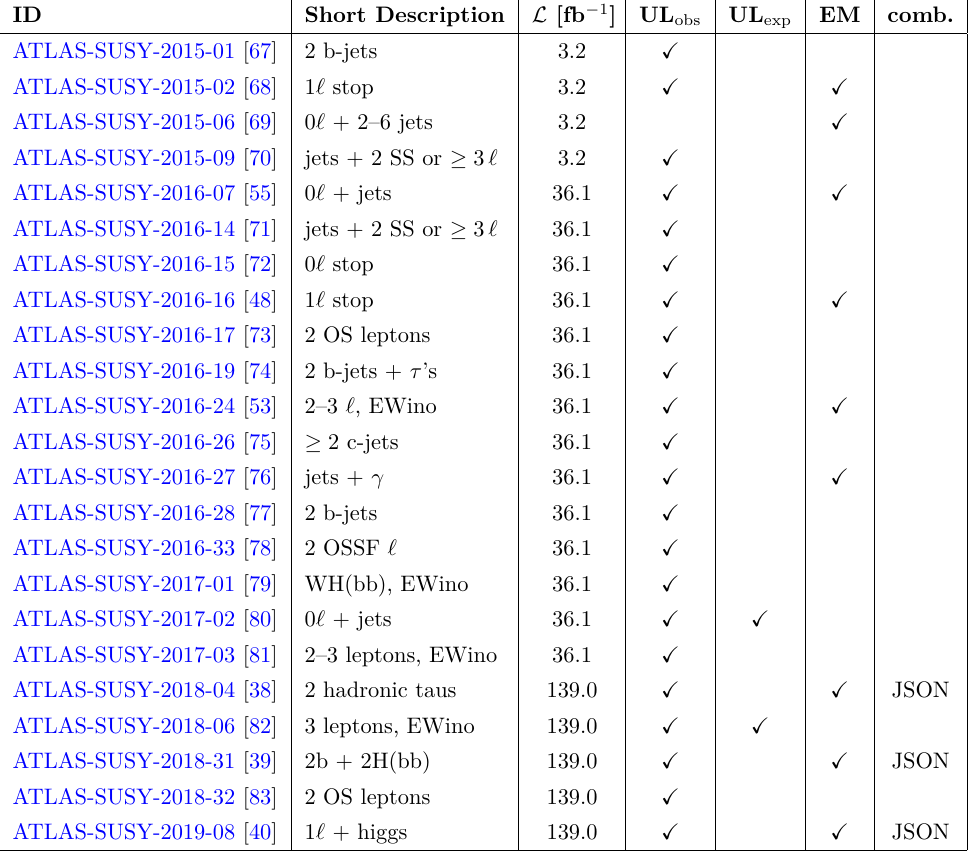
Table 5 . List of ATLAS Run 2 analyses and their types of results in the SModelS v1.2.4